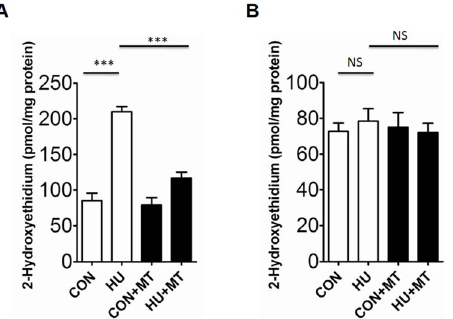
Figure 2. Superoxide levels in rat cerebral (A) and mesenteric (B) vascular smooth muscle cells. The superoxide generation was analyzed by HPLC-based method after staining with DHE. The 2- hydroxyethidium peak reflected the amount of superoxide formed in rat cerebral and mesenteric vascular smooth muscle cells. CON, control; HU, hindlimb unweighting; CON + MT, mitoTEMPO-treated control; HU + MT, mitoTEMPO-treated HU. DHE, dihydroethidium; HPLC, high- performance liquid chromatography. Values are mean 6 SEM. *** P , 0.001 for HU vs . control or HU + MT.